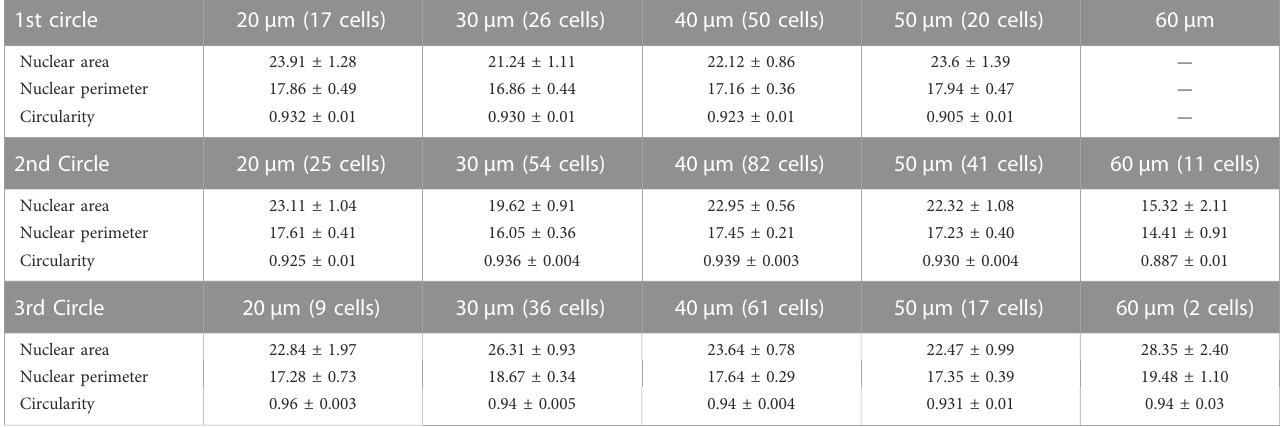
TABLE 4 Nuclear area, perimeter, and circularity of neurons at speci fi c distance from plaques of varying sizes. 1st circle